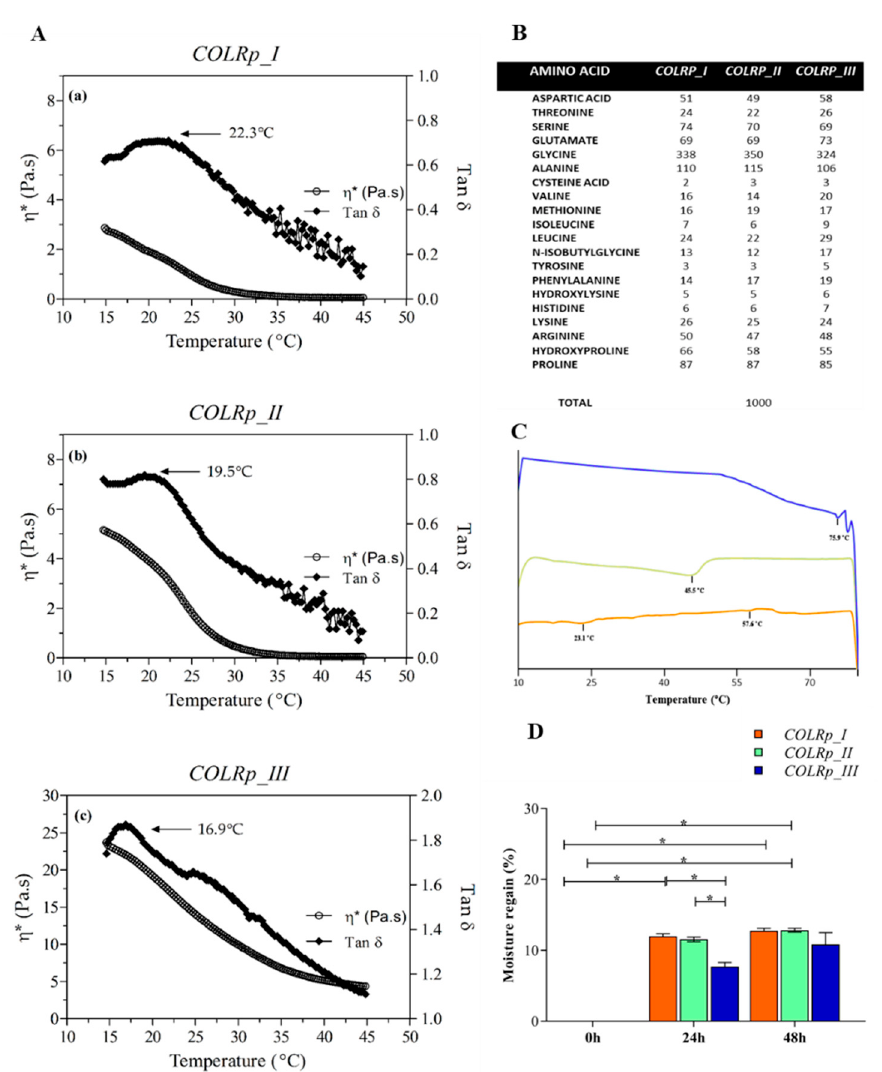
Figure 3. Physicochemical properties of Greenland halibut skin collagens. ( A ) Rheological properties of COLRp_I , COLRp_II, and COLRp_III collagens presented as the temperature dependence of η * (Pa.s) and tan δ . ( B ) The amino acid contents of collagens. ( C ) Micro-DSC thermograms. ( D ) Moisture regain (%) of extracted collagens. Statistically significant differences were determined using one-way ANOVA following a post hoc Tukey´s test. The asterisks (*) denote a statistically significant difference ( p < 0.05). Values represent the mean ± SD of at least three individual measurements.